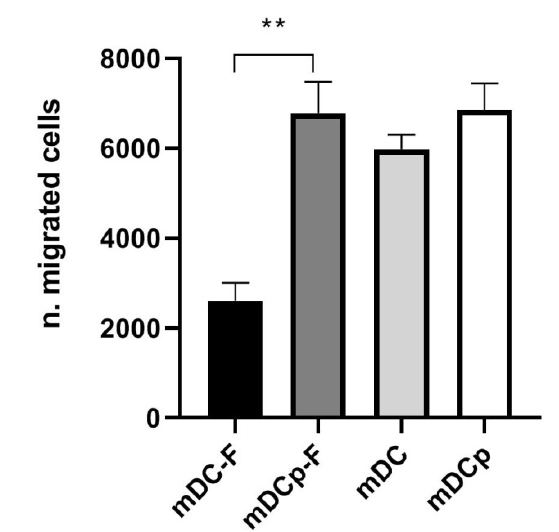
Figure 4. CCL21 induced migration. The ability of mature DC to migrate toward the CCR7 ligands CCL21 was evaluated in a trans-well migration assay. After 3 h incubation at 37 °C, DC migrated in the lower chamber were counted by flow cytometry. The results of three experiments are represented as mean ± SD. ** p < 0.01.